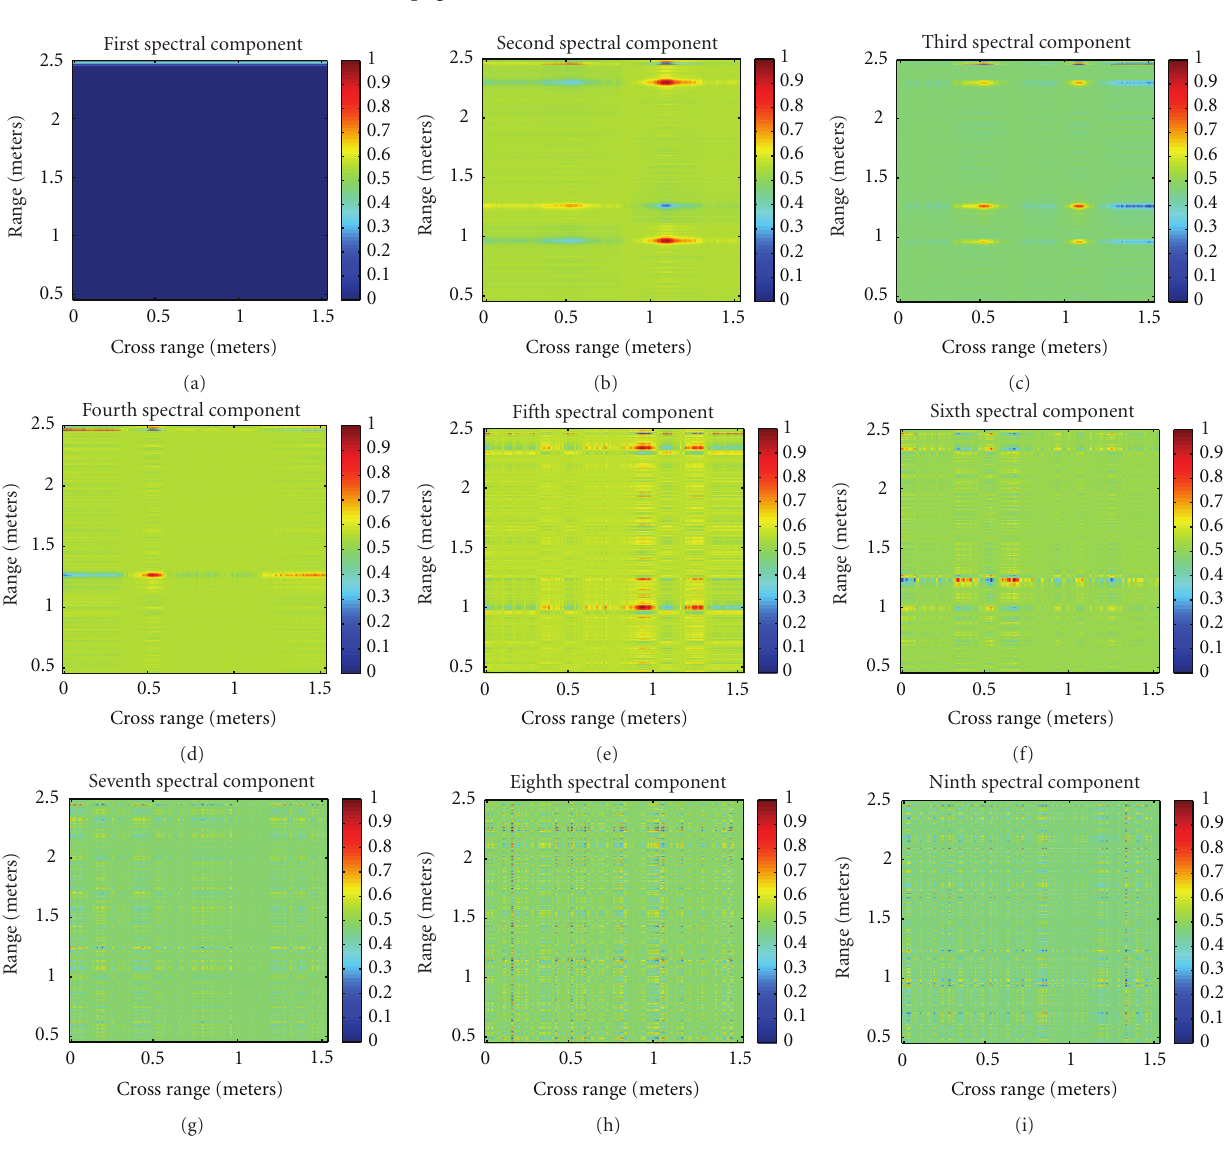
Figure 11: Example 2: Multiple (three) targets: di ff erent spectral